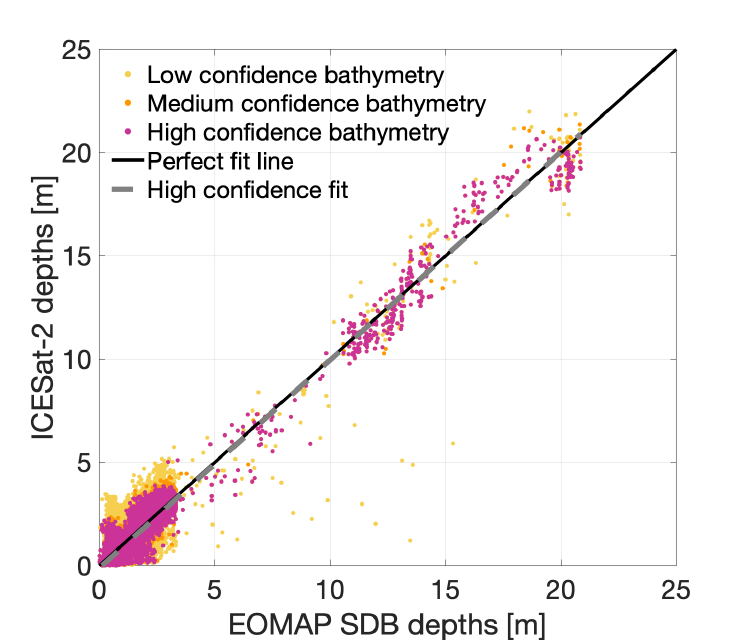
Figure 10. Bias plot comparing the depth of Heron Reef, Australia from ICESat-2 and EOMAP. Depths are metres below the EGM2008 geoid. A perfect fit line (black) is shown along with a linear fit of all high confidence data (grey).